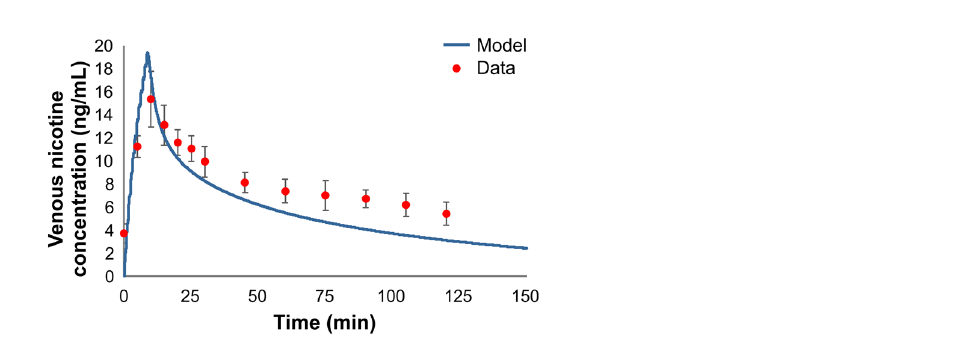
Figure 13. Simulation of the time-course kinetic data during and after a single use of a conventional cigarette 28 . Subjects were directed to take 1 puff every 45 s over a total of 9 min. The average yield was reported as 1.1 mg with subjects consuming 1.33 cigarettes over the 9 min. Points represent data from the study, along with error bars representing one standard deviation and solid lines represent simulation